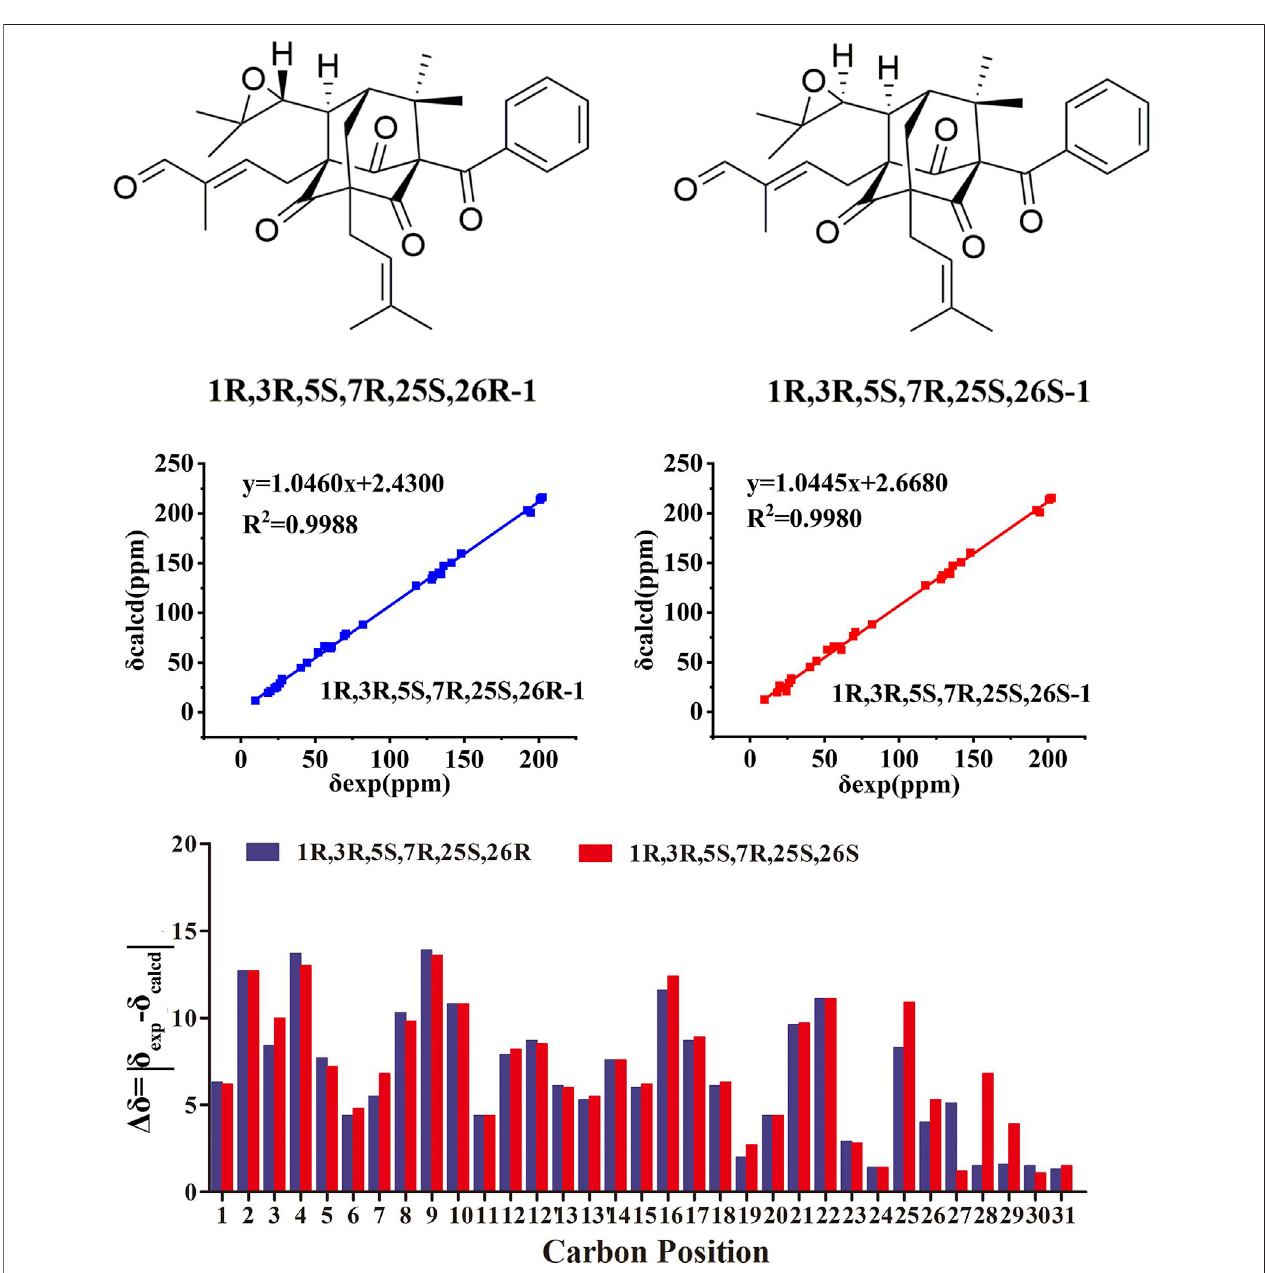
FIGURE 3 | NMR calculations of compound 1